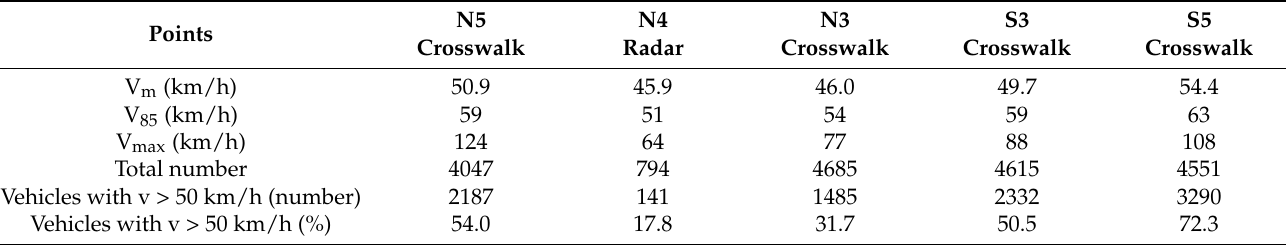
Table 4. Values of selected variables at control points in Arrankudiaga Figure 8. Speed at each controlled point in Arrankudiaga (Spain): ( a ) southbound, ( b ) northbound.